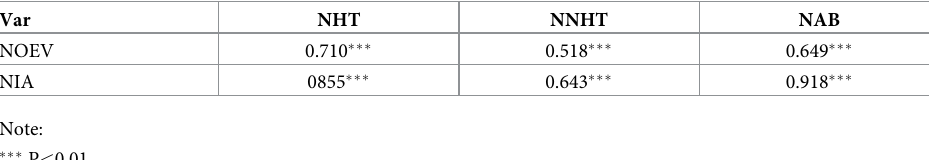
Table 1. Correlation analysis of input and output